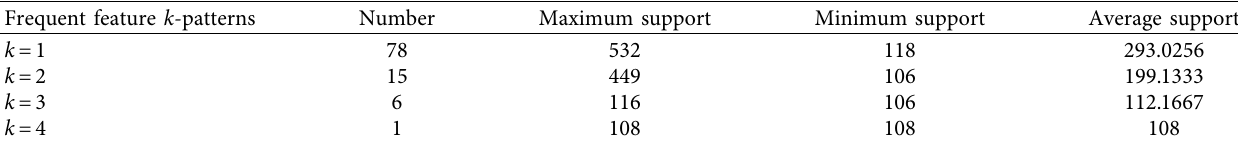
Table 6: Frequent feature pattern mining results based on the equal-width discretization coding method.